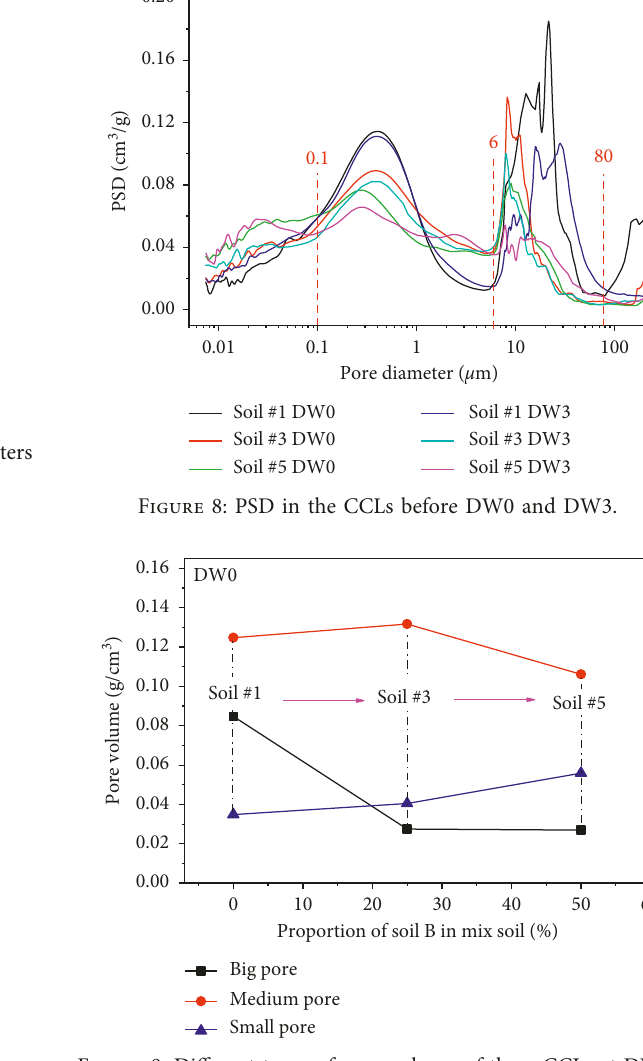
Figure 9: Different types of pore volume of three CCLs at DW0.